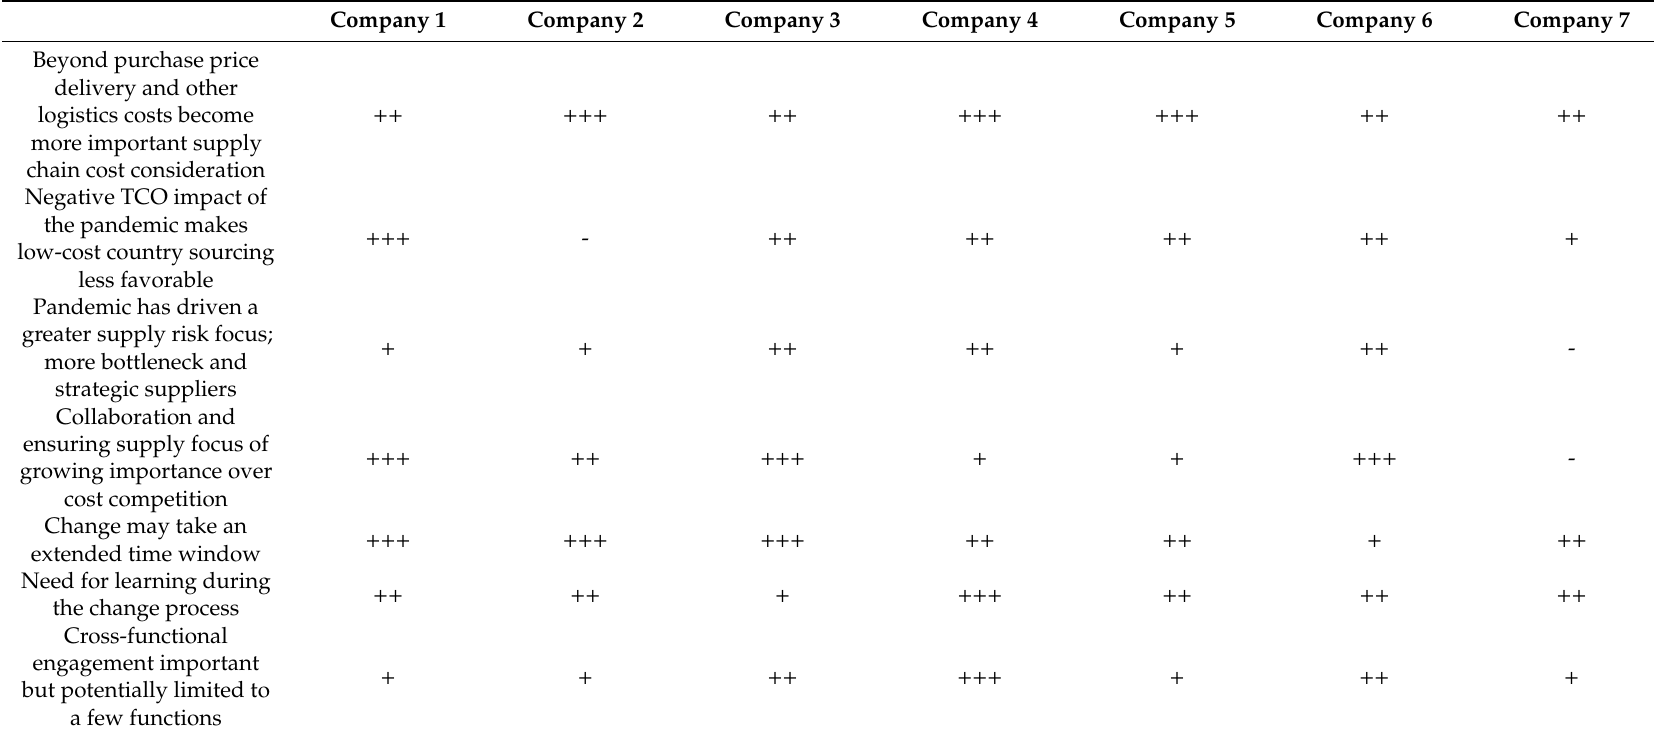
Table 4. Overview of